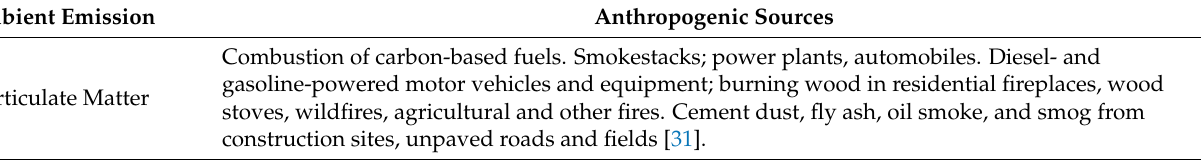
Table 8. Anthropogenic Sources of the Highest Impact Ambient Emissions. Ambient